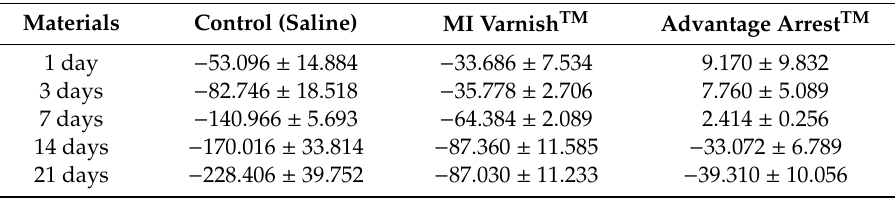
Figure 7. Comparison of the change in mean enamel Hounsfield unit value at a depth of μ m between groups at each time point. Table 6. Mean ± standard deviation of the change in enamel Hounsfield unit value at a depth of 40–60 μ m after several treatment durations with the three tested materials.